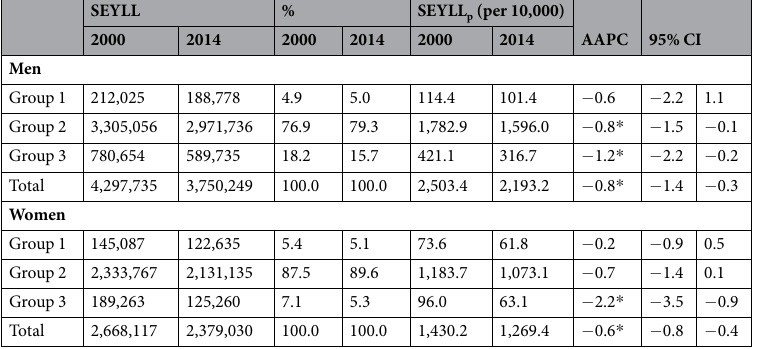
Table 1. Standard expected years of life lost by sex and three broad cause groups, Poland, 2000–2014 SEYLL– Standard Expected Years of life Lost. SEYLL p - Standard Expected Years of life Lost per living persons. AAPC - Average Annual Percentage Change. CI–Confidence Interval. Group 1: Communicable, maternal, perinatal and nutritional conditions. Group 2: Non-communicable diseases. Group 3: Injuries. * p <